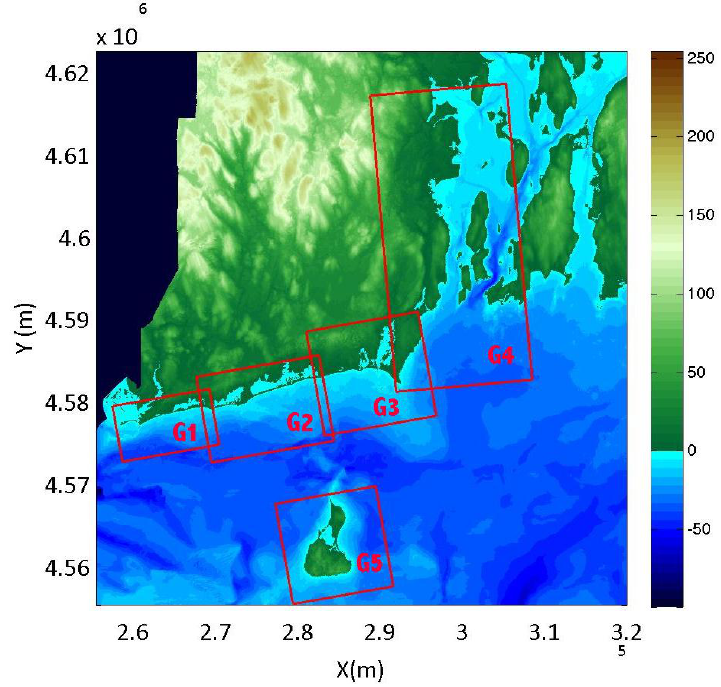
Figure A1. Bathymetry and location of the five computational grids used for STWAVE wave propagation modeling for inundated areas [26]. The G2 grid was used for Charlestown study area.